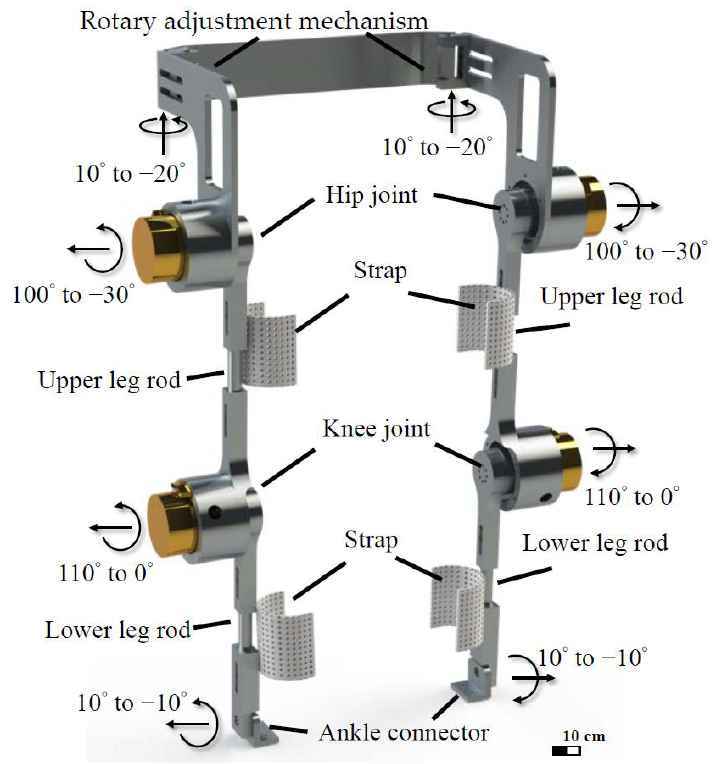
Figure 2. Final design of the LLRE-II.